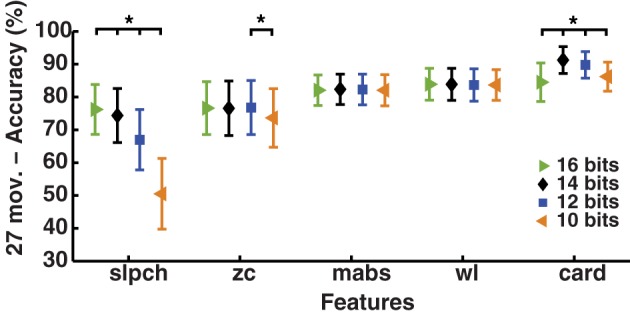
Effect of ADC resolution on MPR accuracy. Change in accuracy of myoelectric pattern recognition (MPR) owing to variations on the resolution of the analog-to-digital conversion (ADC). Simultaneous movements of three degrees of freedom (27 individual movements—SM data) were classified using LDA and single EMG features (Hudgins' set and cardinality). The dynamic part of the contraction was included during signal processing (cTp = 0.7). The marker “*” represents statistical significance at p < 0.05.